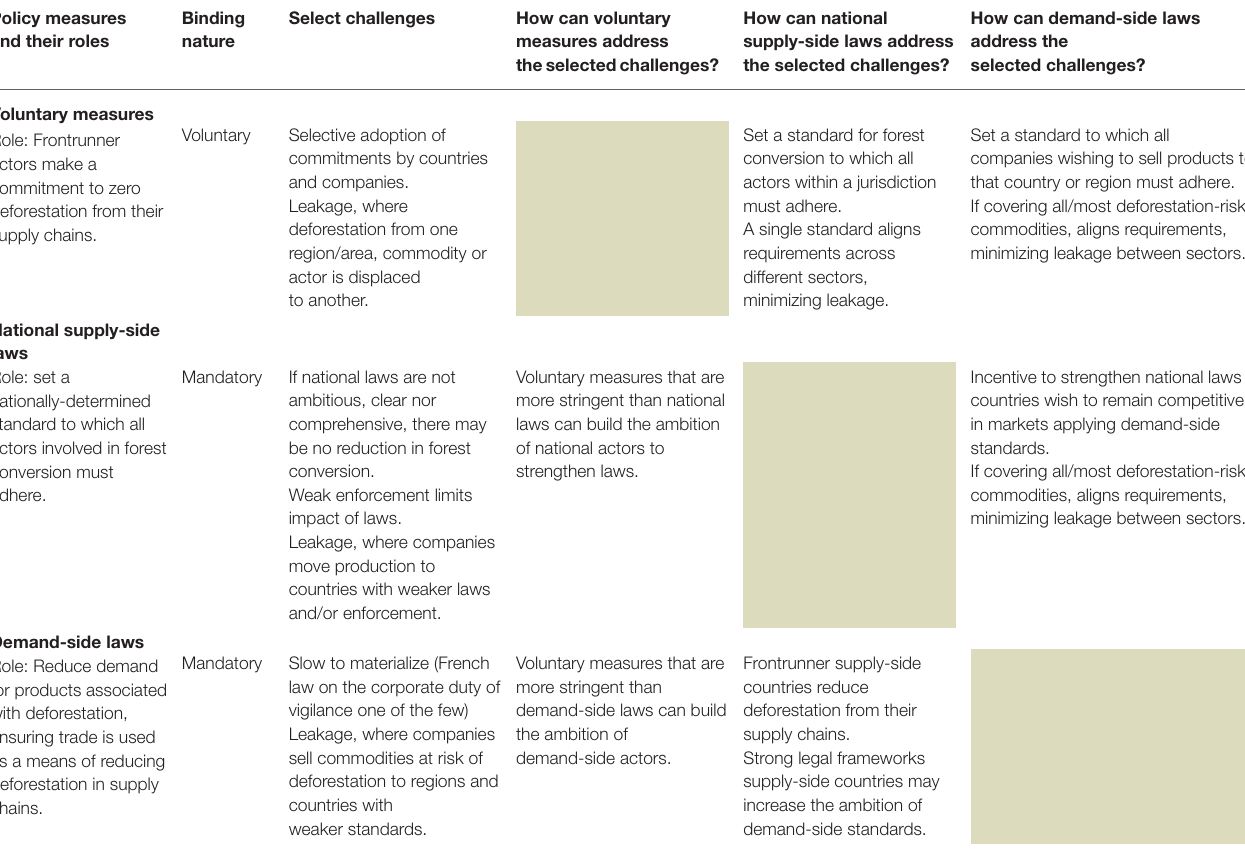
TABLE 1 | Complementarity of policy options for